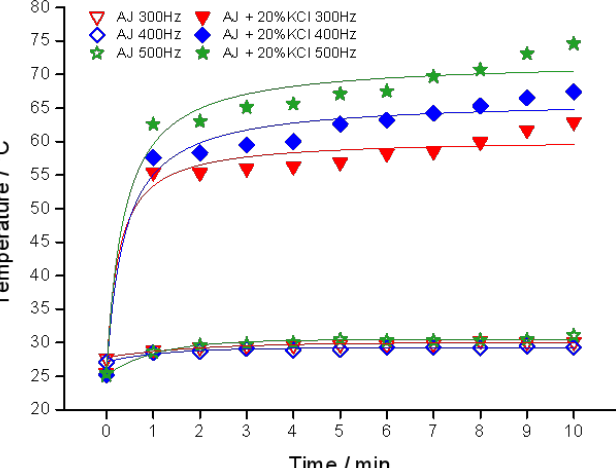
Figure 7. Temperature profile of different frequencies in apple juice (AJ) at 800 V, d 1 = 2 mm, L 1 = 10 cm, N S = 2 × 19.